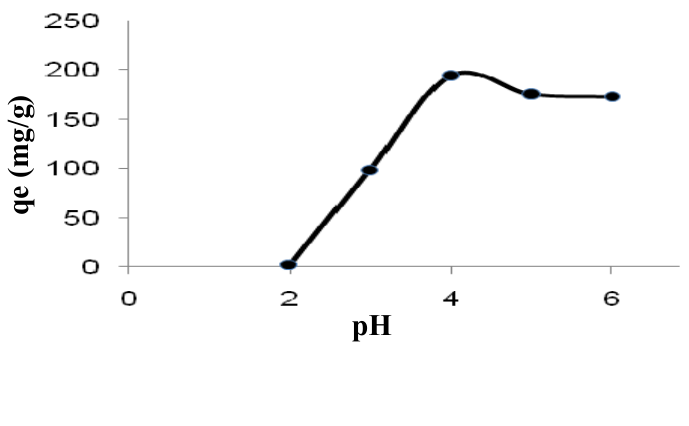
Figure 2. Effect of pH on cadmium biosorption by modified Tamrix articulata wastes at 30 °C.